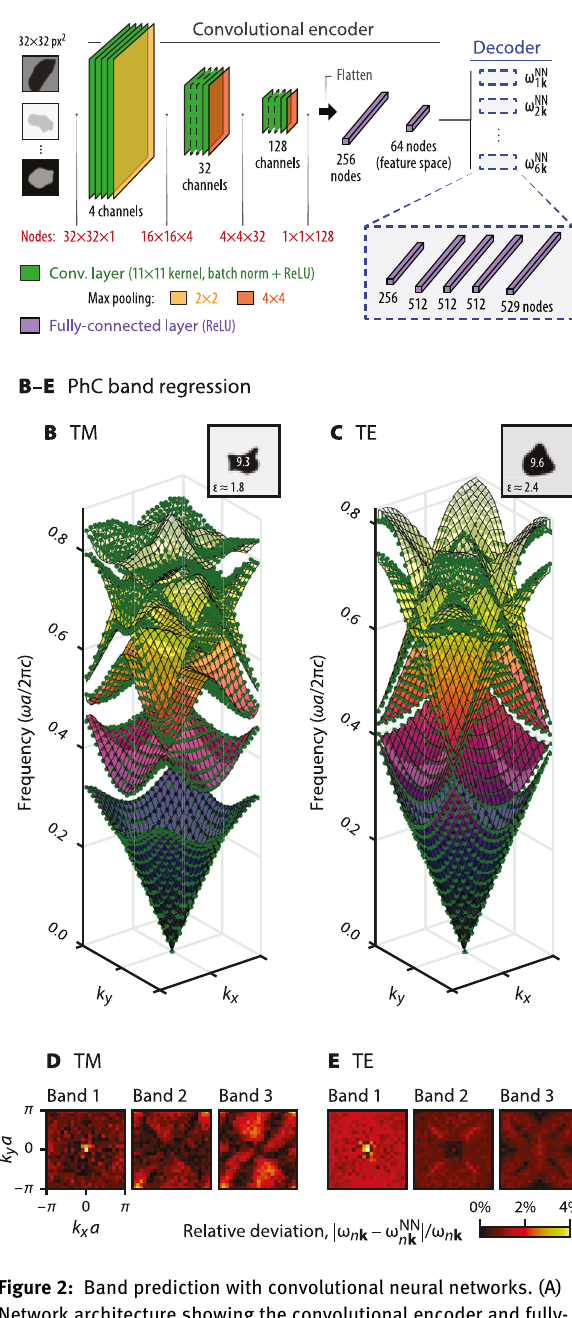
Figure 2: Band prediction with convolutional neural networks. (A) Network architecture showing the convolutional encoder and fully- connecteddecoder(describedindetailinthemaintext).Numbersin red indicate the data size after every network layer. (B – C) Example applications of the trained band-prediction network on test set unit cells in both TM and TE polarizations (green markers, network predictions; surfaces, reference MPB calculations). The chosen unit cells represent worst-case examples due to their large permittivity contrast. (D – E) The relative deviation between network predictions and reference calculations. The relative error is typically very small, on the order of ≲